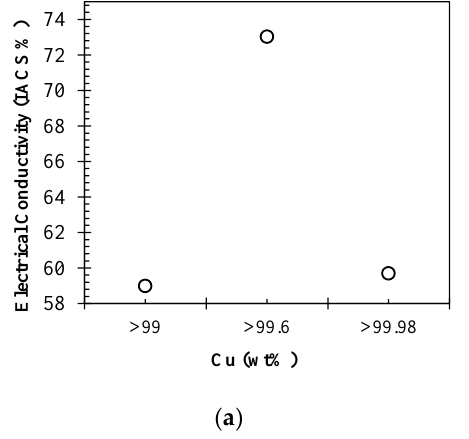
Figure 4. IACS electrical conductivity performance ( a ) and XCT relative density ( b ) for EOS Cu (>99%), Carpenter Additive Cu (>99.6%) and EOS CuCP (>99.98%) high-purity copper feedstock.